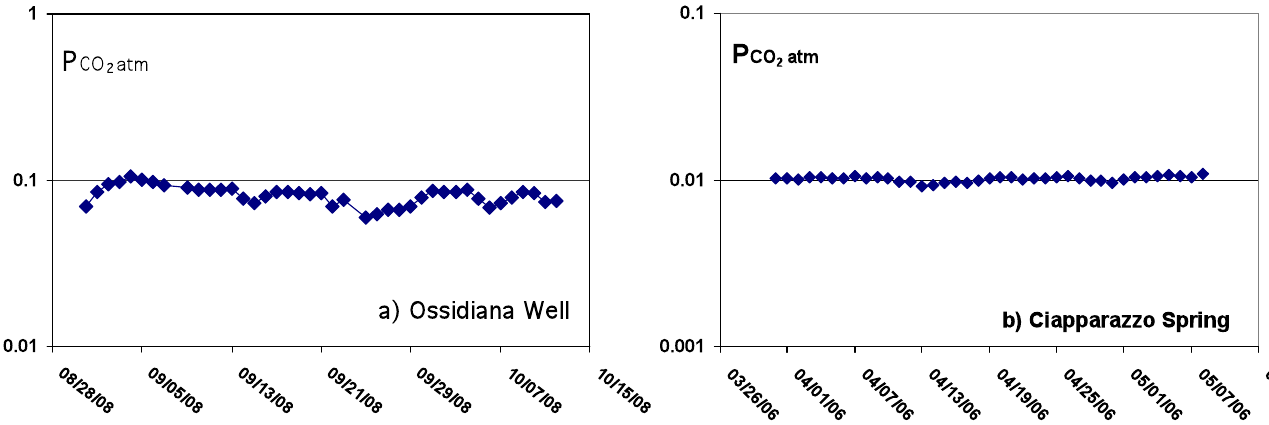
Figure 7. Field measurements of P for the Ossidiana well (a) and the Ciapparazzo spring (b). Ossidiana well (temperature, 40 ˚C; salinity, 30 mS/cm) CO2 is located in the village of Stromboli (Stromboli Island), and Ciapparazzo spring is located on the flank of Mt. Etna (temperature, 13 ˚C; salinity, 700